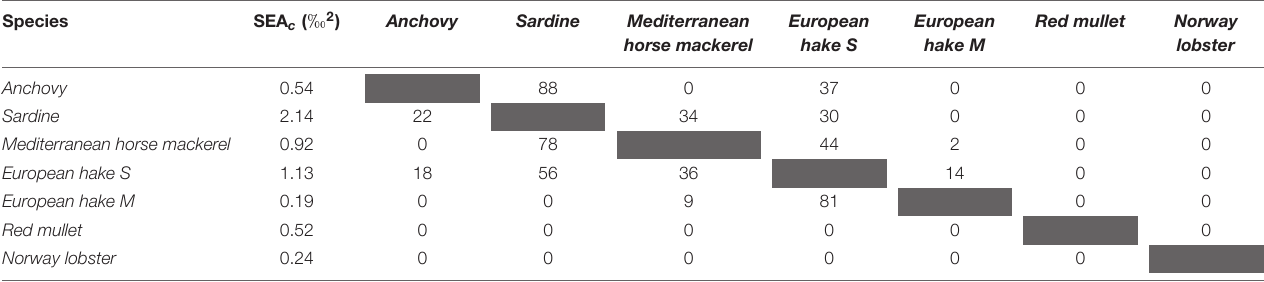
TABLE 4 | Standard Ellipse Area corrected for small sample (SEA c ) and SEA c overlap percentage between the species sampled in the Northern area of the Adriatic Sea (values indicate SEA c overlap of the species in the row with the species in the